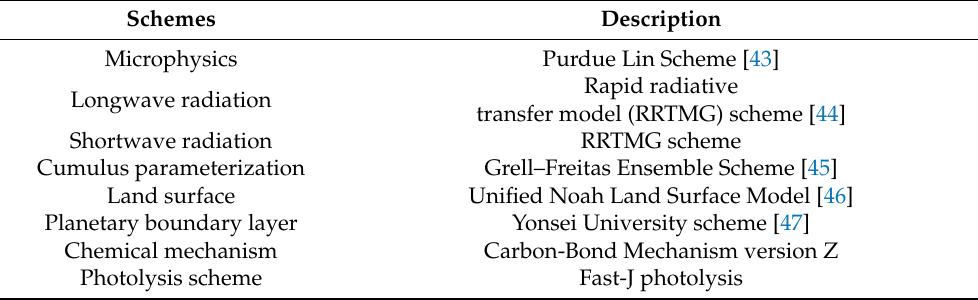
Table 1. Model configuration